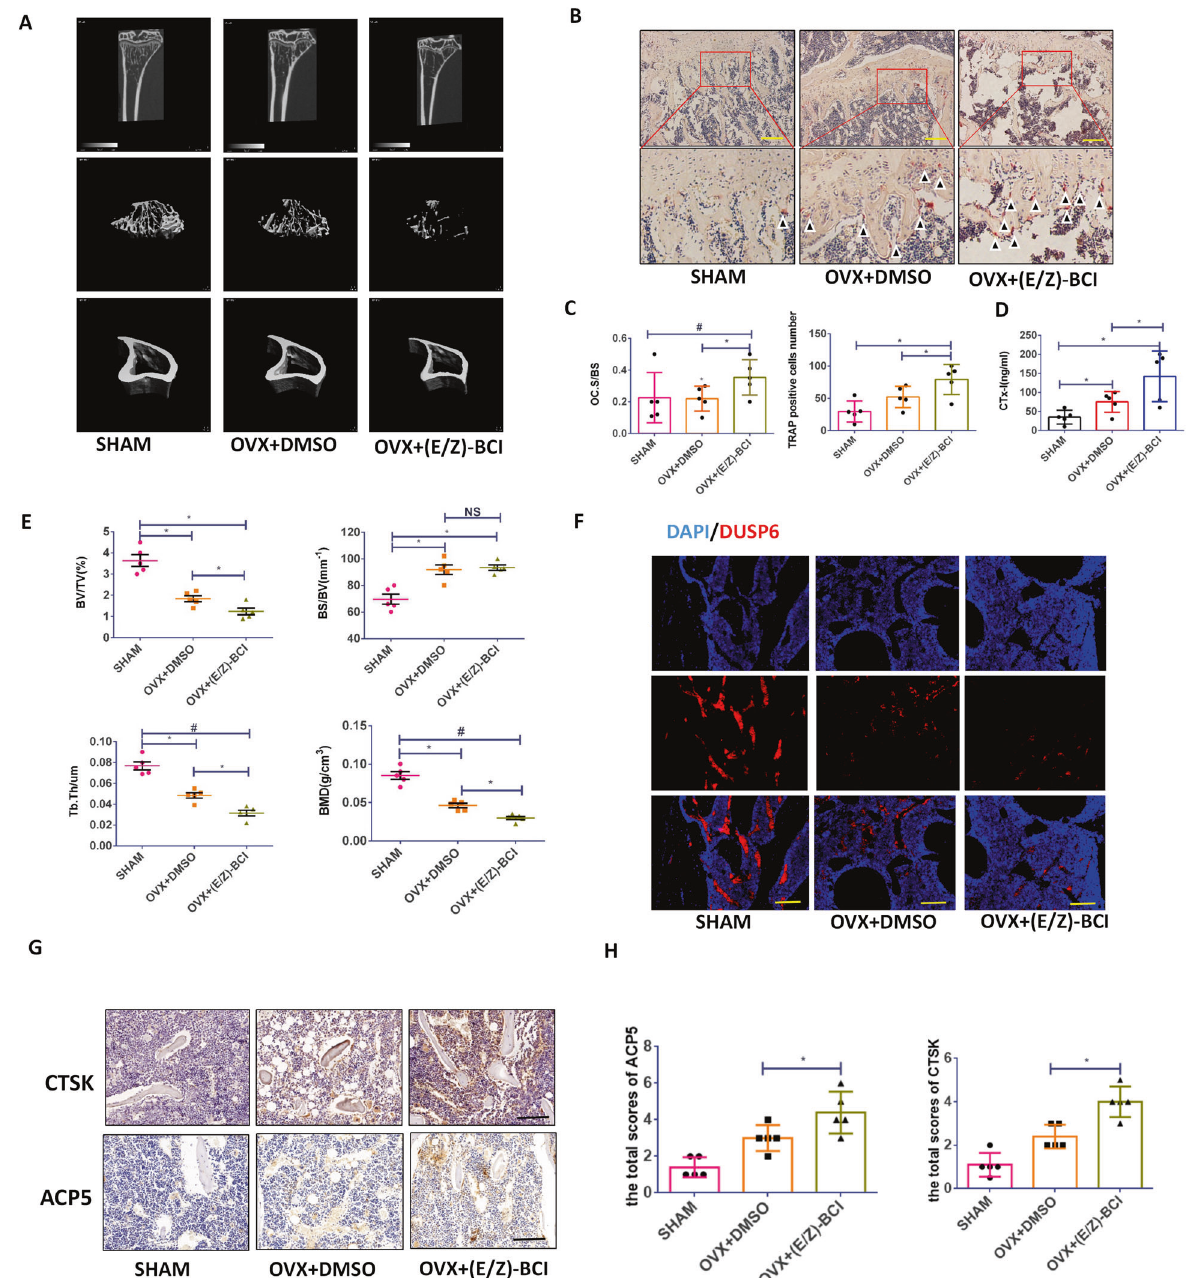
Fig. 4 DUSP6 inhibitor accelerated the bone loss in vivo. Experimental osteoporosis model was established. Mice were treated with (E/Z)- BCI for analysis the function of DUSP6 in vivo. A uCT was analyzed to con fi rm the bone loss. B The tibia was collected from the indicated groups and TRAP staining was analyzed to detect the osteoclasts. Original scale bars: 500 μ m. C Quantitative analysis was used to determine the average TRAP-positive cell numbers from fi ve different versions and the TRAP-positive cell bone surface/bone surface. D Serum cross-linked C-telopeptide 1 levels were determined by ELISA (mouse CTx-I ELISA kit; Cusabio, Wuhan, China). E The bone volume/tissue volume (BV/TV), trabecular thickness (Tb.Th), trabecular number (Tb.N), and trabecular separation (Tb.Sp) were measured to evaluate the microstructure. F The tibia was collected from the indicated groups. Immuno fl uorescence assay was carried out to explore the expression of DUSP6 in the indicated groups. Original scale bars: 500 μ m.The tibia was collected from the indicated groups. Immunohistochemistry and quantitative analysis were carried out to explore the expression of ACP5 and CTSK, which were identi fi ed as osteoclast markers ( G , H ). Original scale bars: 500 μ m. Data in all bar graphs are expressed as mean ± SD ( n = 5). * P < 0.05, # P < MiR-181a accelerates osteoclastogenesis in vitro DUSP6 luciferase activity, but had no effect on the activity of BMMs were treated with RANKL or RANKL with a negative control the mutated luciferase reported (Fig. 5G). Overall, these results (NC) mimic, miR-181a mimic, NC inhibitor, and miR-181a inhibitor. The demonstrated that miR-181a was enhanced under pathological miR-181a mimic inhibited DUSP6 expression during RANKL-induced conditions and that it inhibited the expression of DUSP6 osteoclastogenesis and induced osteoclast differentiation, whereas in vitro.